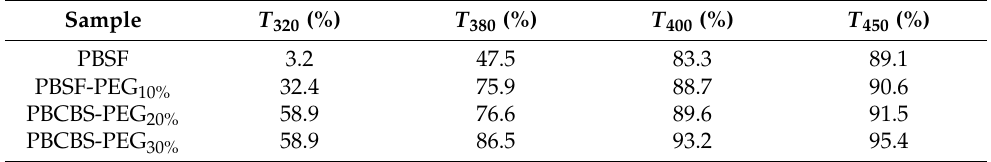
Table 5. UV–Vis transmittance values at maximum UV-blocking wavelength of the polyester